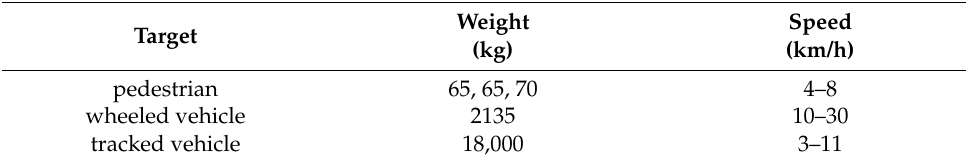
Table 3. Target movement